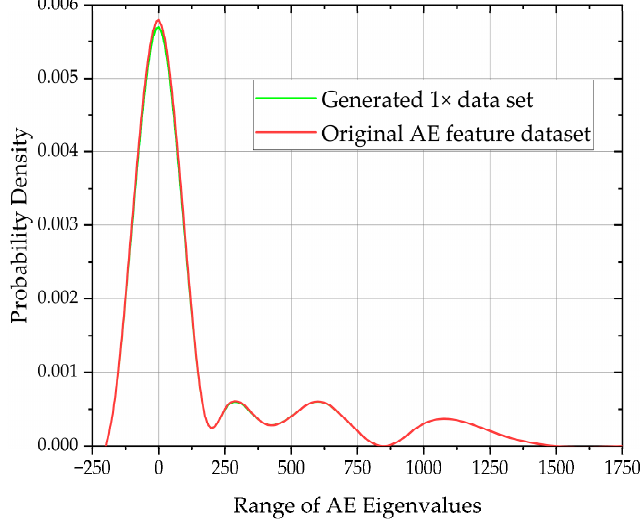
Figure 10. Kernel density estimation plots for the original AE feature dataset and the generated 1 × data.